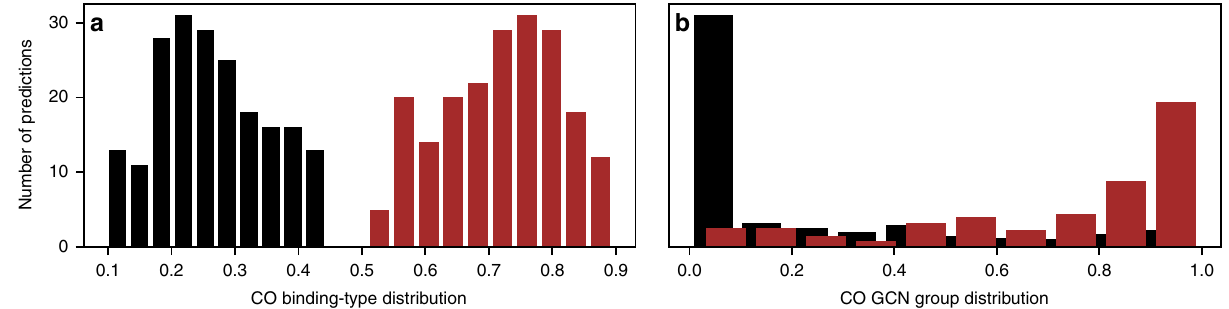
Fig. 7 Histograms of neural network ensemble predictions with the greatest uncertainty indicated in Figure 6b, c. Distribution of predicted binding- types for CO on Pt(111) at 0.5 ML ( a ) for atop (brown bars) and bridge (black bars). Also shown is the distribution of predicted generalized coordination number (GCN) groups ( b ) for group 8 (brown bars) and group 10 (black bars) for CO on Pt(110) at 1